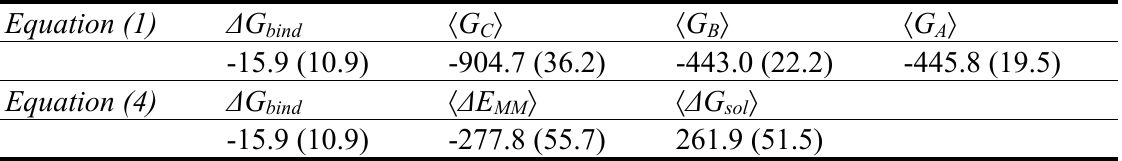
in kcal/mol, according bind